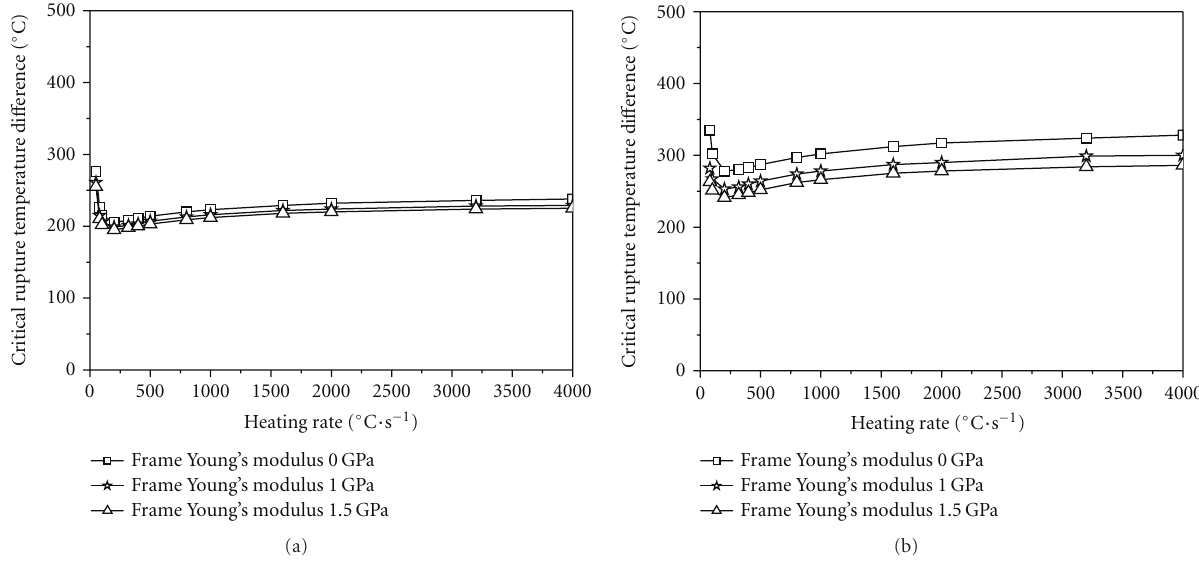
Figure 3: The critical rupture temperature di ff erence versus heating rate for di ff erent frame Young’s modulus with the thermal shock initial temperature (a) 1000 ◦ C and (b) 1500 ◦